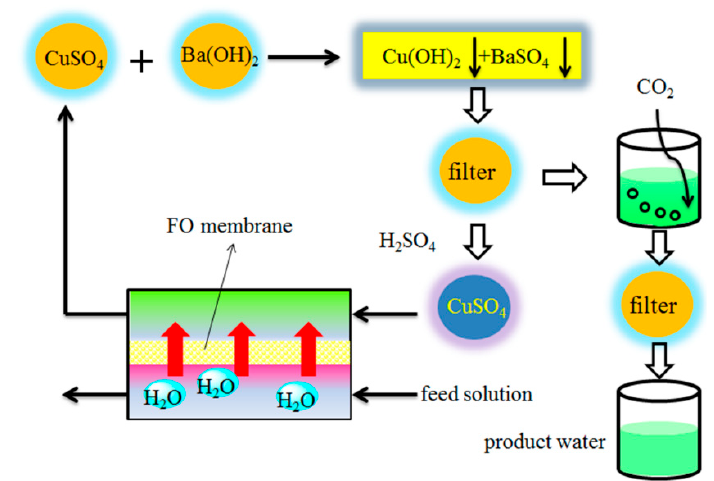
Figure 1. Schematic illustration of the use of precipitate method to regenerate CuSO 4 draw solution (DS) after forward osmosis (FO) process.